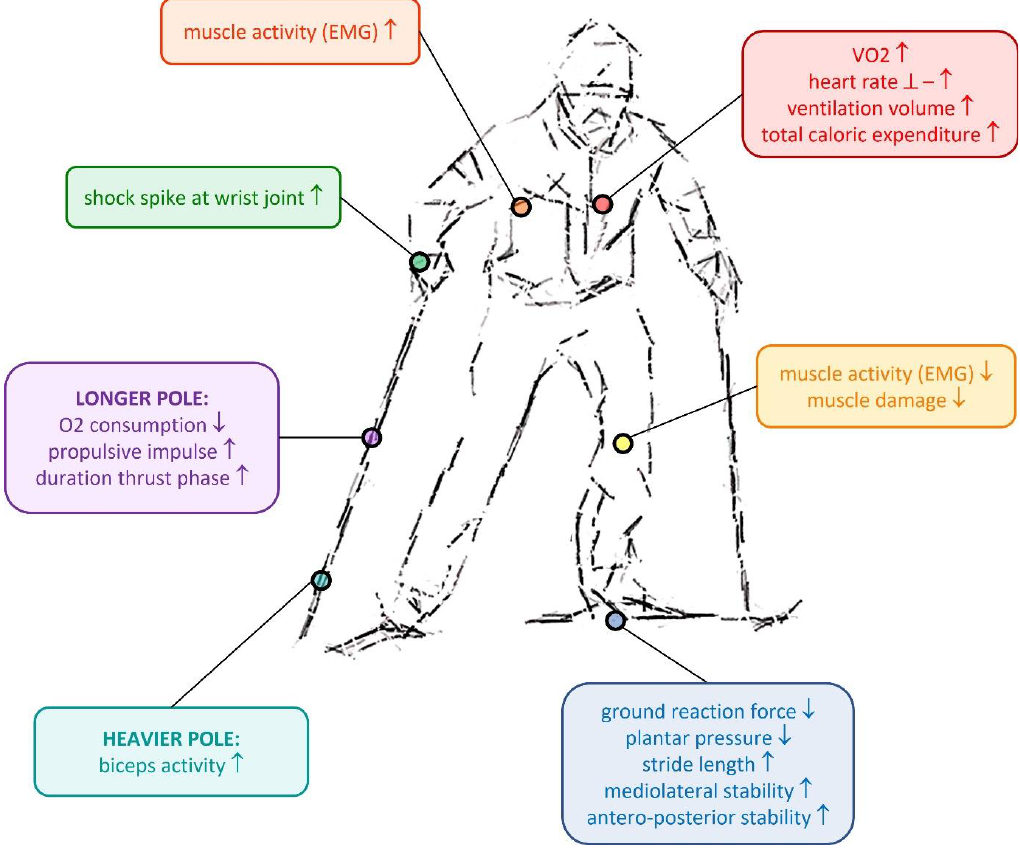
Figure 2. Summary of pole-induced effects on the human body; ↓ = decrease, ↑ = increase, ⊥ = no